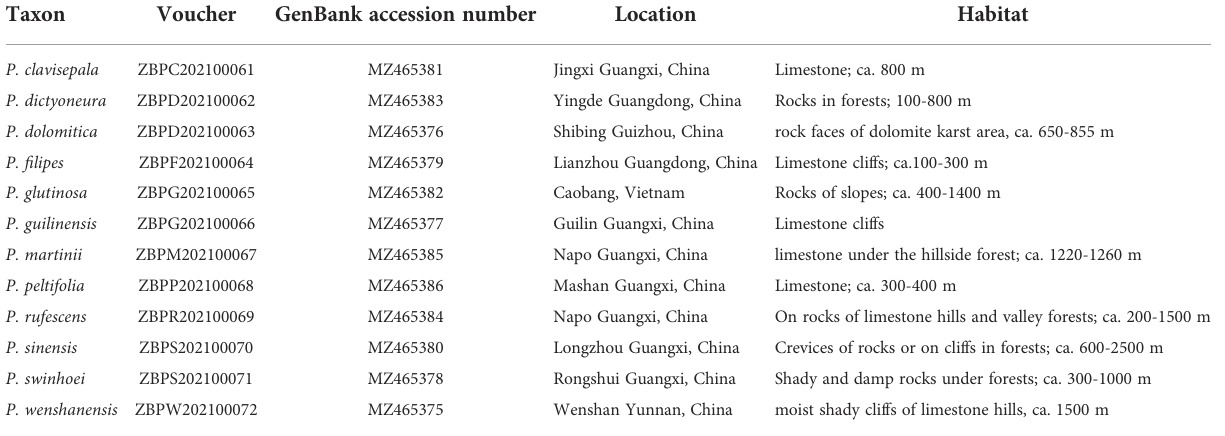
TABLE 1 Sources of material from twelve Paraboea